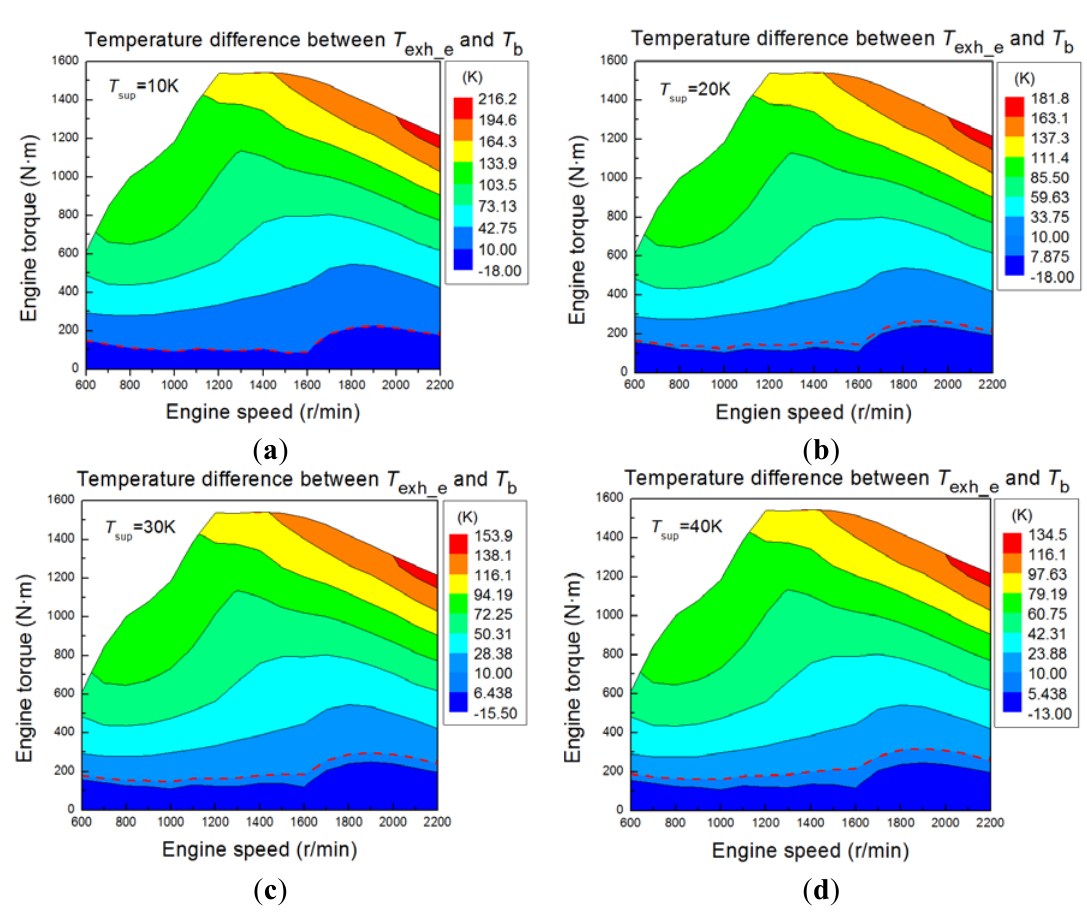
and T : ( a ) T = 10 K; exh_e b sup